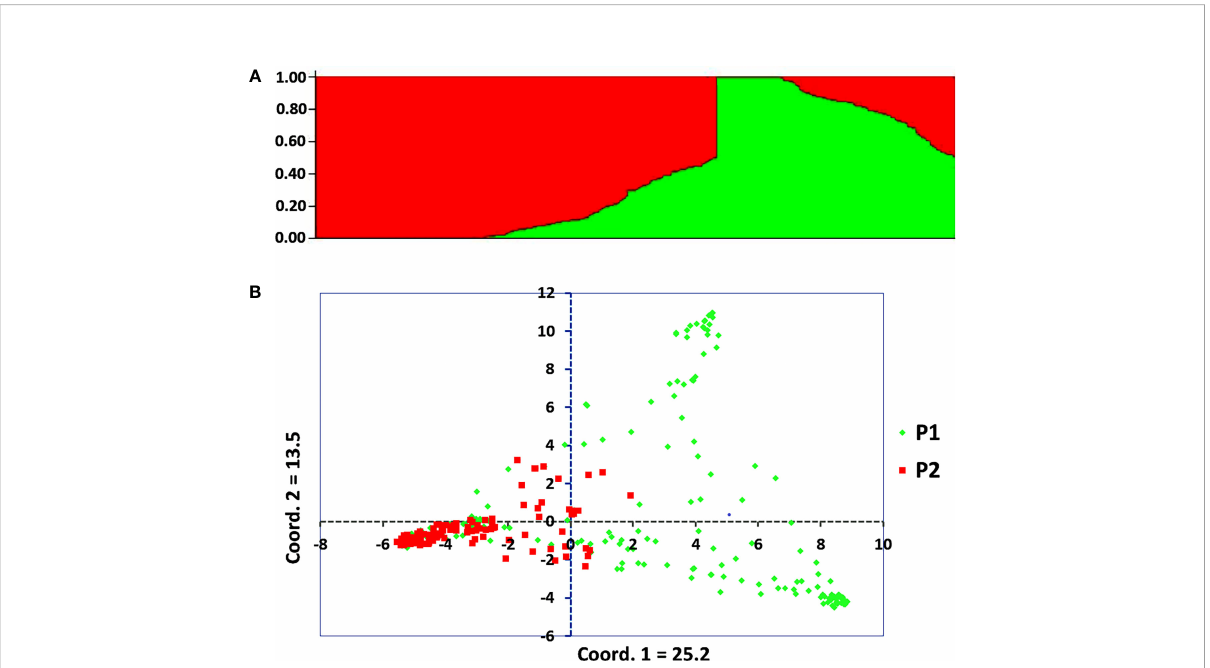
FIGURE 2 Graphical display of the population structure for 309 sorghum accessions analyzed using genotypic data of 3,143 SNP markers with MAF > 5%. (A) Population genetic structure plot of the sorghum accessions for K = 2, and (B) PCoA scatter plot depicting the clustering pattern of the 309 individual accessions, with population one (P1) and population two (P2) comprising 121 and 188 accessions, respectively.